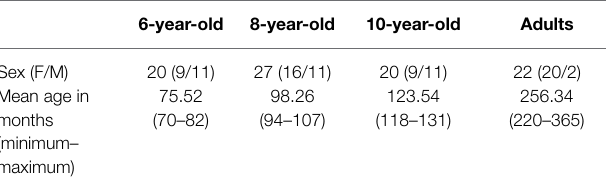
TABLE 6 | Summary of participants’ characteristics in Experiment